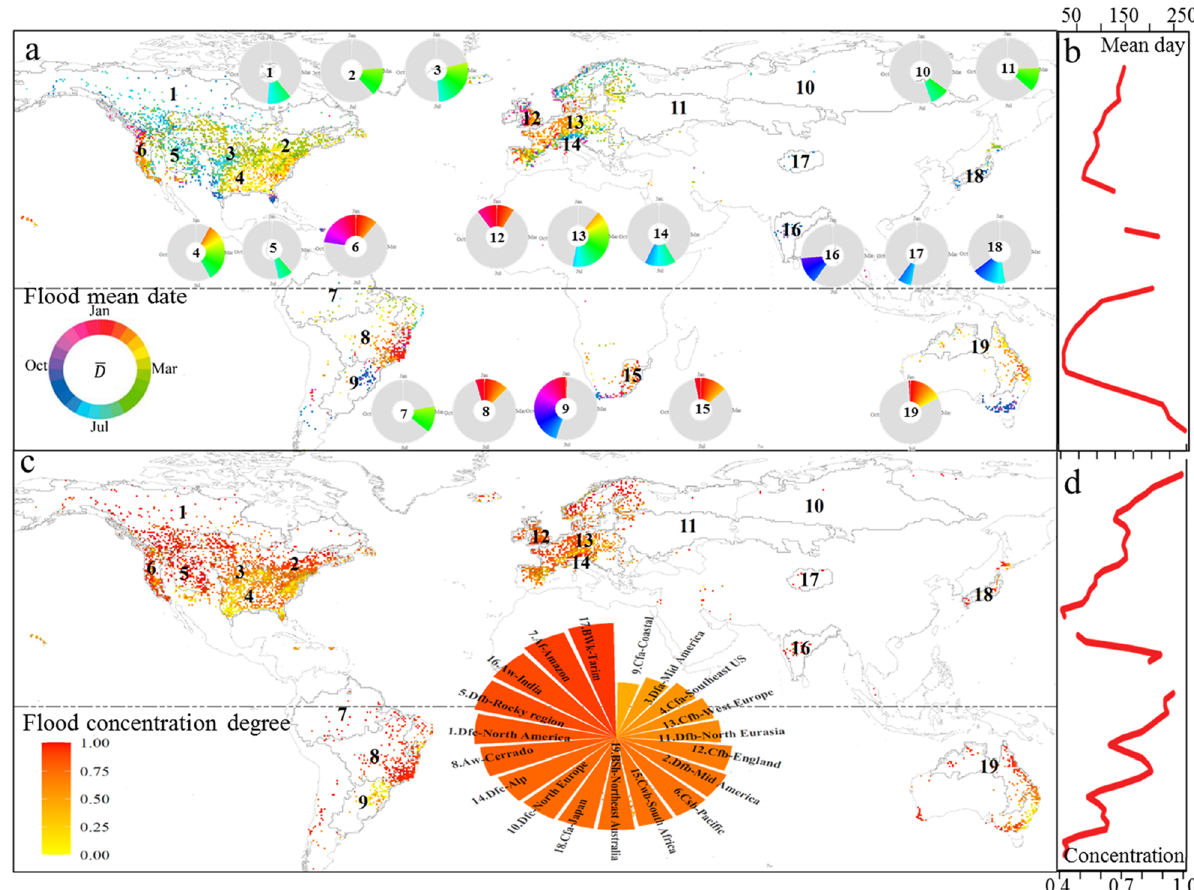
Figure 1. The spatial pattern of flood timing during 1970–2010: ( a ) mean flood date, displayed as circular for each hotspot; ( b ) latitude averaged mean flood date; ( c ) flood concentration index around corresponding mean occurrence date; ( d ) latitude averaged flood concentration. Both the mean and concentration of flooding date are aggregated in 19 hotspots based on the Köeppen Climate Classification System 43 . The names of these hotspots are listed below: 1. Dfc-North America, 2. Dfb-Mid America, 3. Dfa-Mid America, 4. Cfa-Southeast US, 5. Dfb-Rocky region, 6. Csb-Pacific,7. Am-Amazon, 8. Aw-Cerrado, 9. Cfa-Coastal, 10.